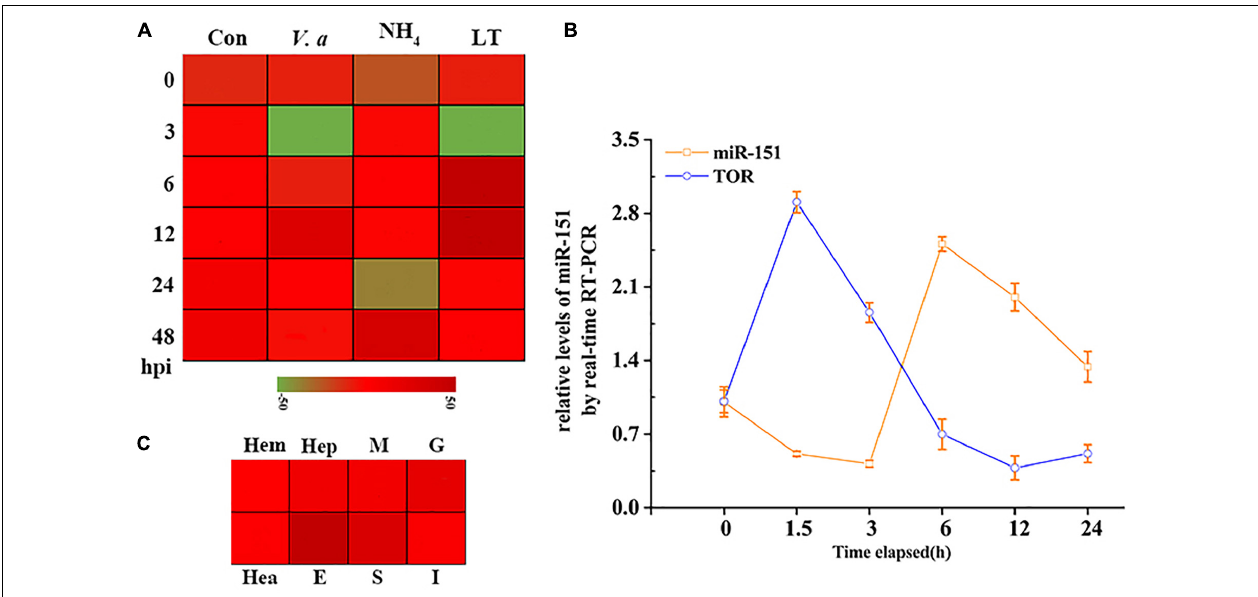
FIGURE 3 | Expression pattern analysis of PvTOR and pva-miR-151. (A) Transcriptional profiling of pva-miR-151. The values calculated by qRNA data were shown as a heat map. (B) Different tissues expression profiles of pva-miR-151 in shrimp. The colors of the bar shown to the right of the heat map varied from red to green, representing the relative expression levels from high to low. Hepatopancreatic (Hep), hemolymph (Hem), heart (Hea), muscle (M), gill (G), stomach (S), intestine (I), and eye (E). (C) pva-miR-151 and PvTOR expression patterns in shrimp under low-temperature stress. cDNAs were synthesized from total RNA extracted from various tissues of shrimp. The expression levels of pva-miR-151 were normalized using U6, and PvTOR was normalized using β -actin. Error bars represented standard deviations of the mean values from three independent